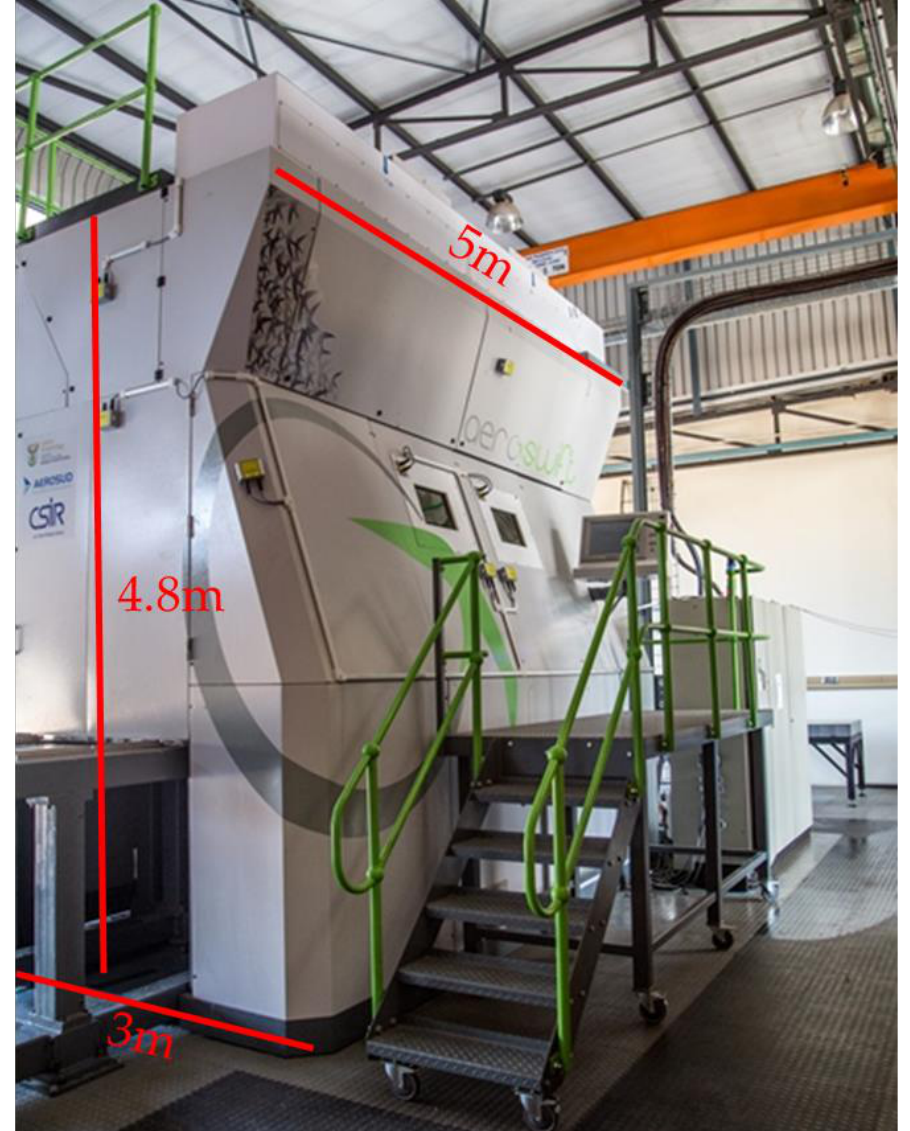
Figure 1. Aeroswift 3D printing machine.